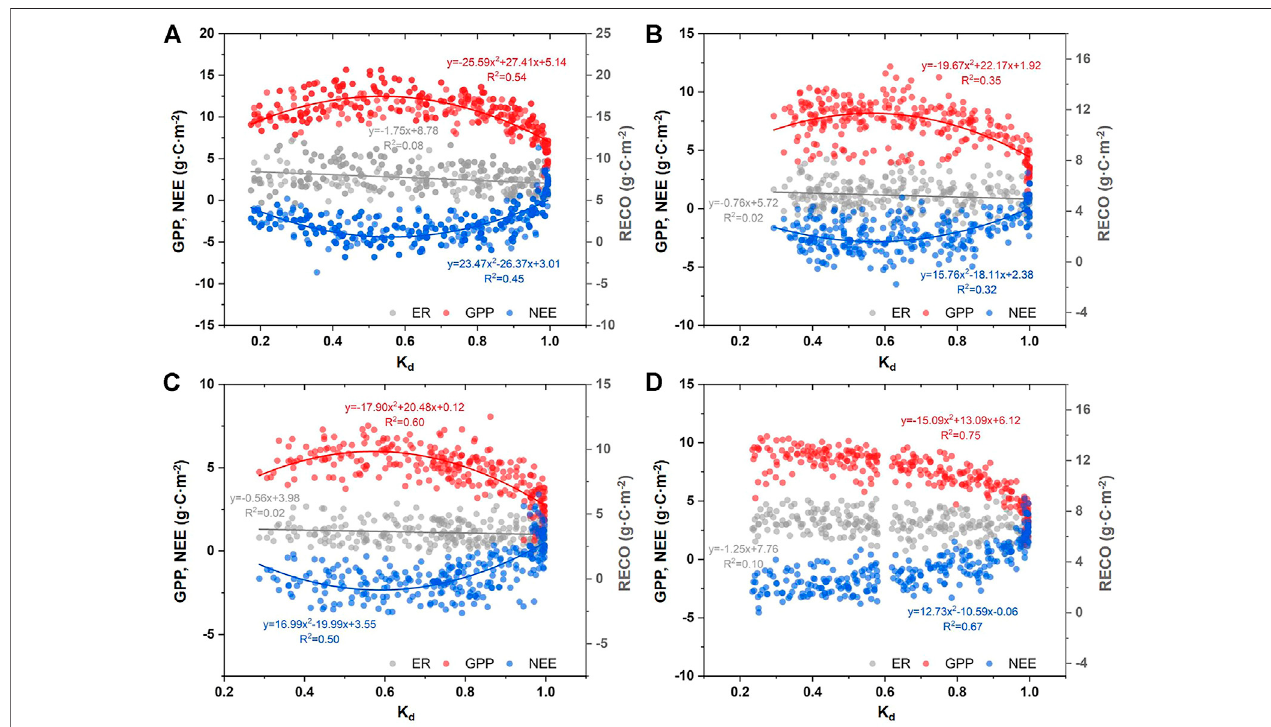
FIGURE 9 | The relationship among K d and ecosystem carbon fl uxes. (A – D) are Cha, Qia, Din and MPM sites, respectively.